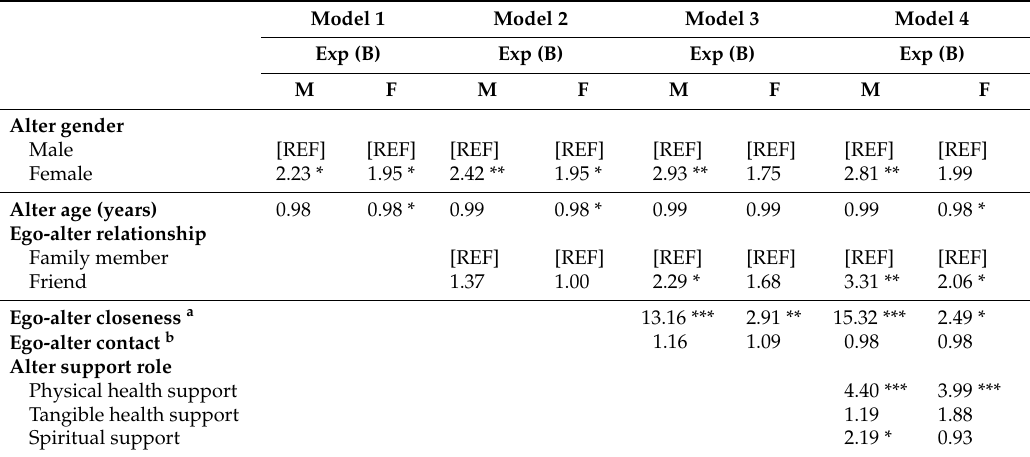
Table 4. Adjusted Odds of an Alter Being Named as an Emotional Support Provider, Stratified by Ego Gender ( n = 463). Model 1 Model 2 Model 3 Model